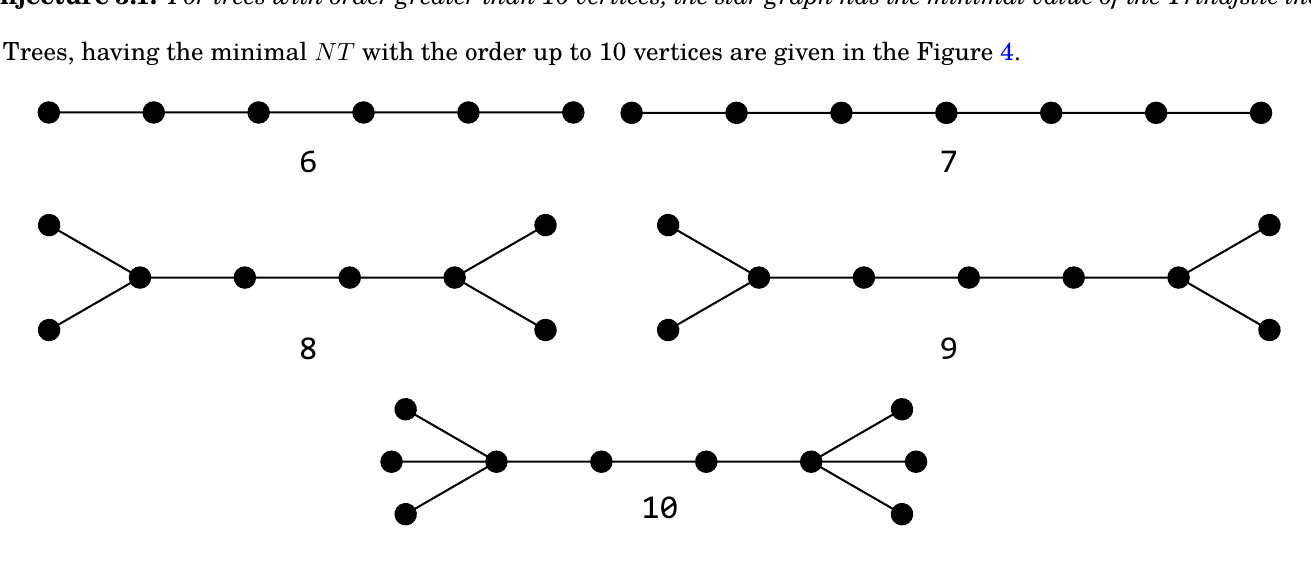
Figure 4: Trees with the maximal Trinajsti ´ c